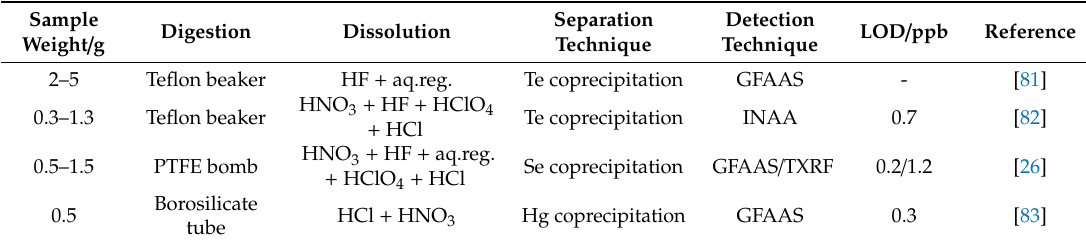
Table 3. Preconcentration of Au by various precipitation methods .